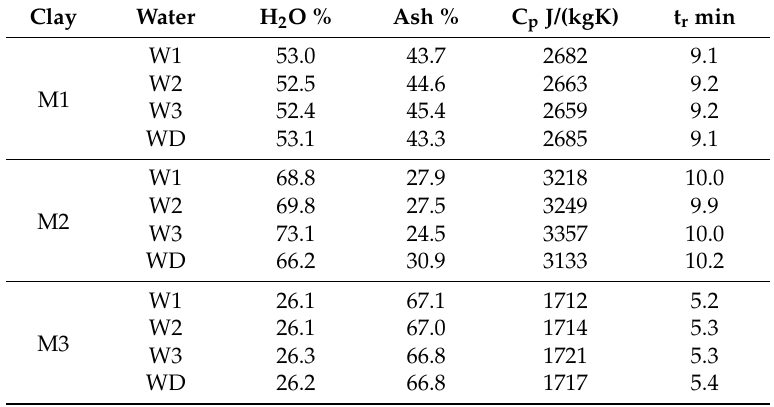
Table 7. The thermal parameters of the pastes prepared to a hardness of 300